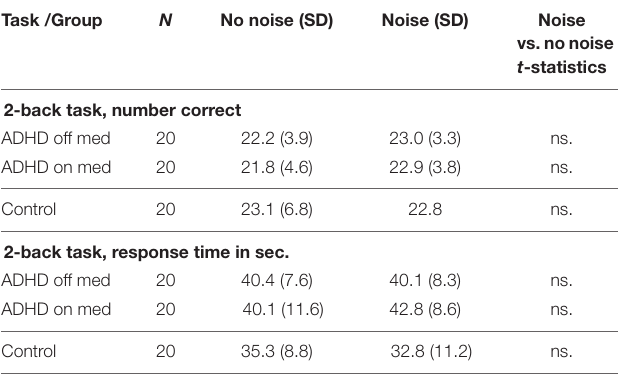
TABLE 3 | Results on verbal 2-back task for ADHD and control children in noise and in silence. Number of correct responses and response times are